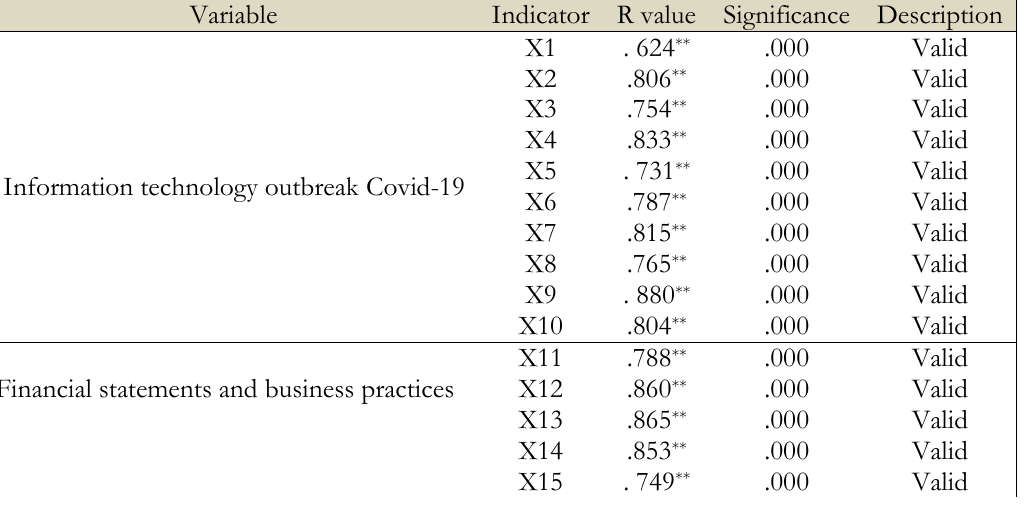
Table 2. The results of this study show that all questionnaires are valid and